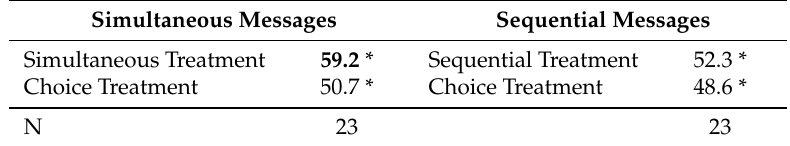
Table 4. Frequency of Beliefs in Line with Non-Conflicting Messages(%) a